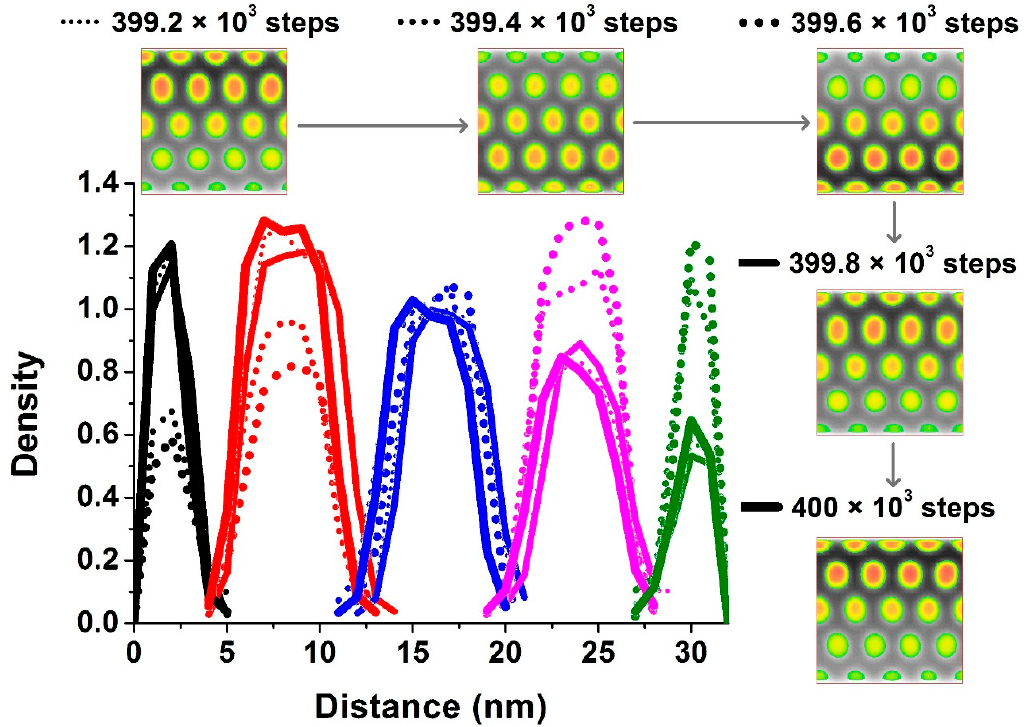
Figure 7. Under YW55 confinement, the average size of the cylinders in each row with the time evolving from 398.0 × 10 3 steps to 400 × 10 3 steps. The green region is selected for the following analysis given in Figure 8.